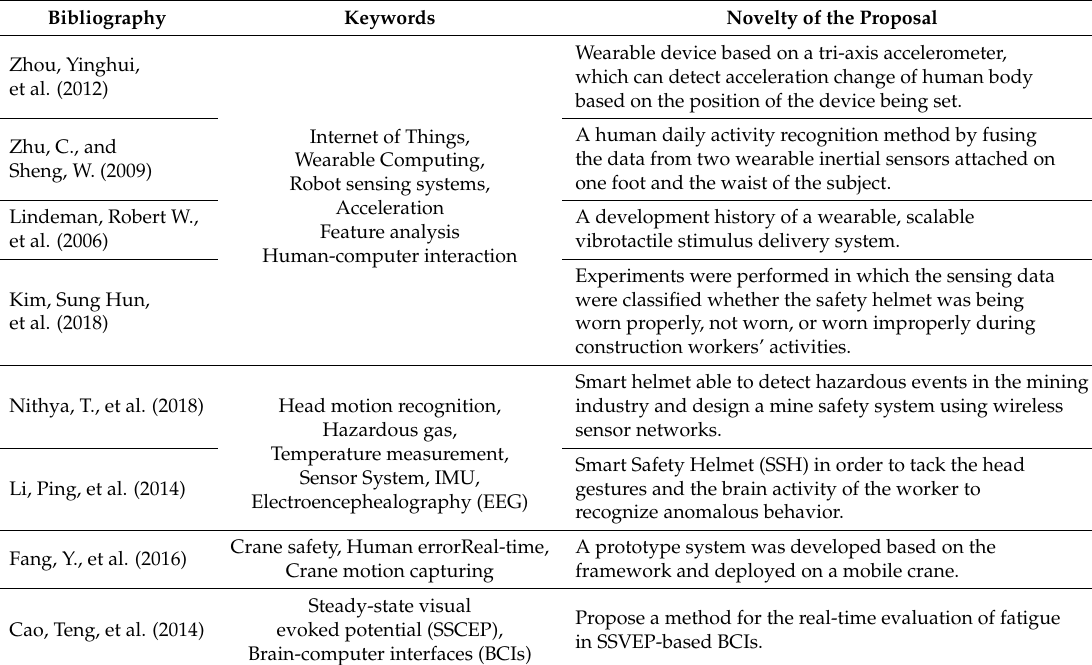
Table 2. Proposals related to sensor